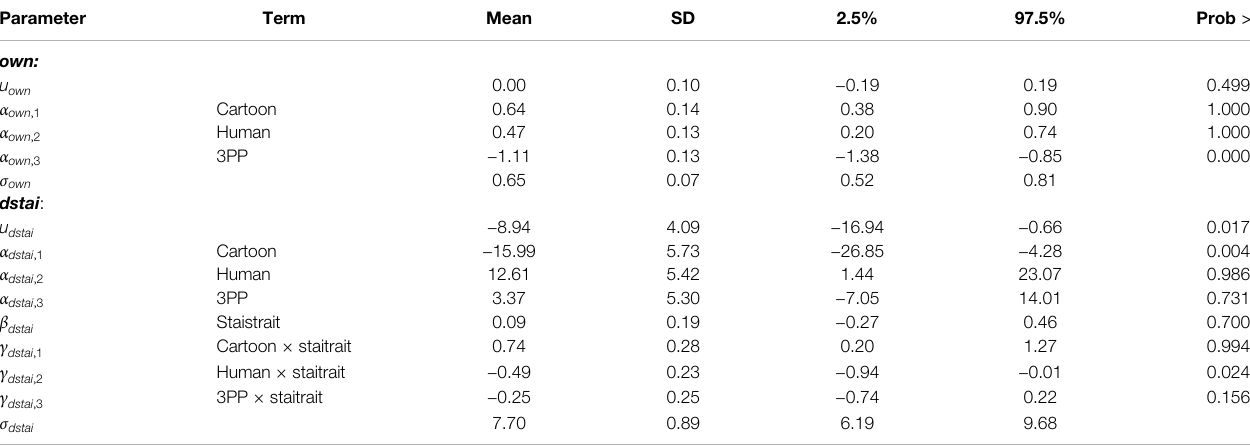
TABLE 4 | Summaries of the posterior distributions of the parameters showing the distribution means, standard deviations, 95% credible intervals. Prob > 0 is the posterior probability that the parameter is positive. Parameter